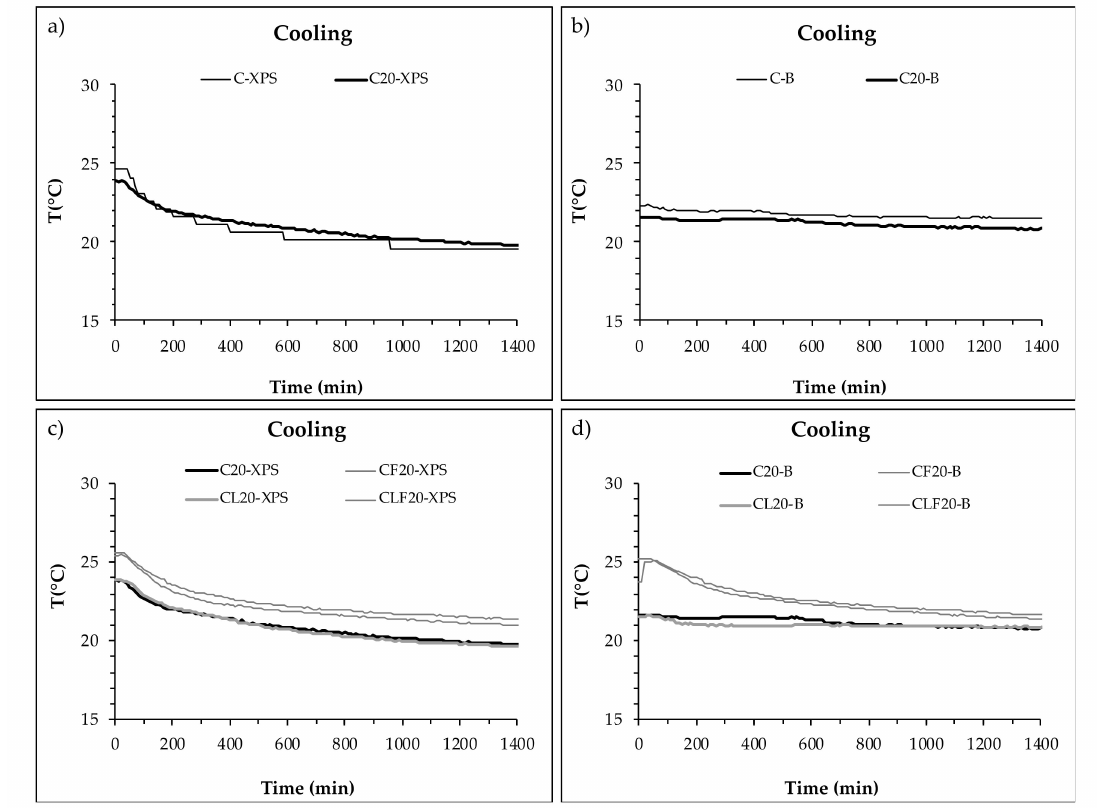
Figure 4. Temperature on both sides of the PCM cement-lime mortar layer during a cooling cycle. ( a ) Inner side (XPS) of C and C 20 plates. ( b ) Outer side (B) of C and C 20 plates. ( c ) Inner side (XPS) of C 20 , CF 20 , CL 20 and CLF 20 samples. ( d ) Outer side (B) of C 20 , CF 20 , CL 20 and CLF 20